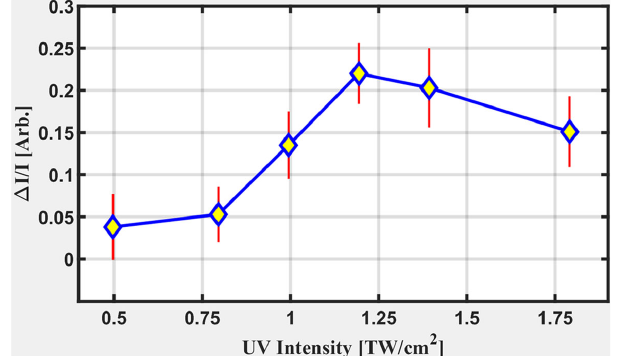
FIG. 19. UV pump-pulse intensity dependence. The ratio of the diffraction pattern difference, Δ I = I, between 1.1 and 2 . 8 Å − 1 is plotted as a function of UV pump-pulse intensity. The delay was chosen between 250 and 300 fs. All data shown in the main text were taken at an intensity of around 1 TW = cm 2 .